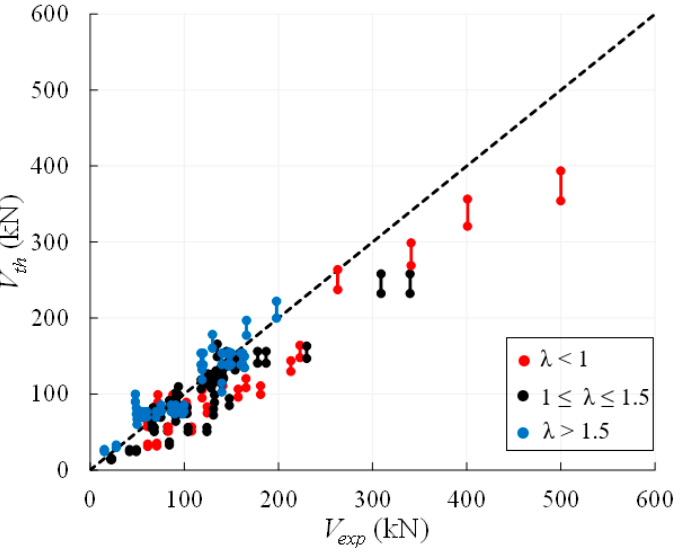
Figure 14. Experimental vs. theoretical results of regular masonry walls provided by Equations (13), (14) and (16) assuming b = 1.5. Table 12. Mean, standard deviation and CoV associated with the ratio ρ